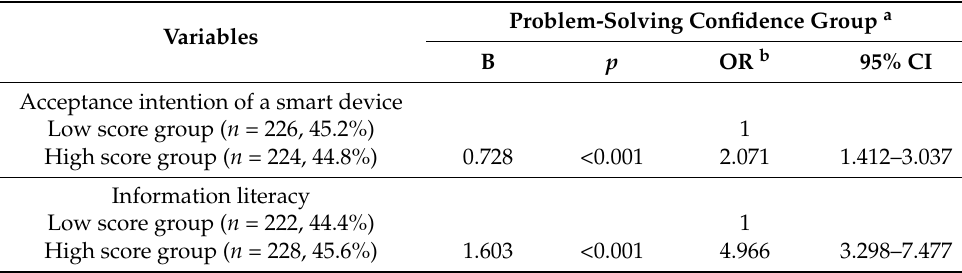
Table 4. Logistic regression of variables according to problem-solving confidence group.